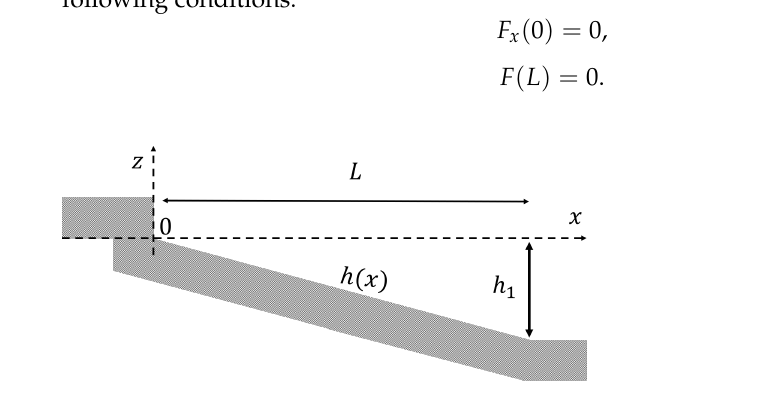
Figure 3. Triangular (right-angled) semi-closed